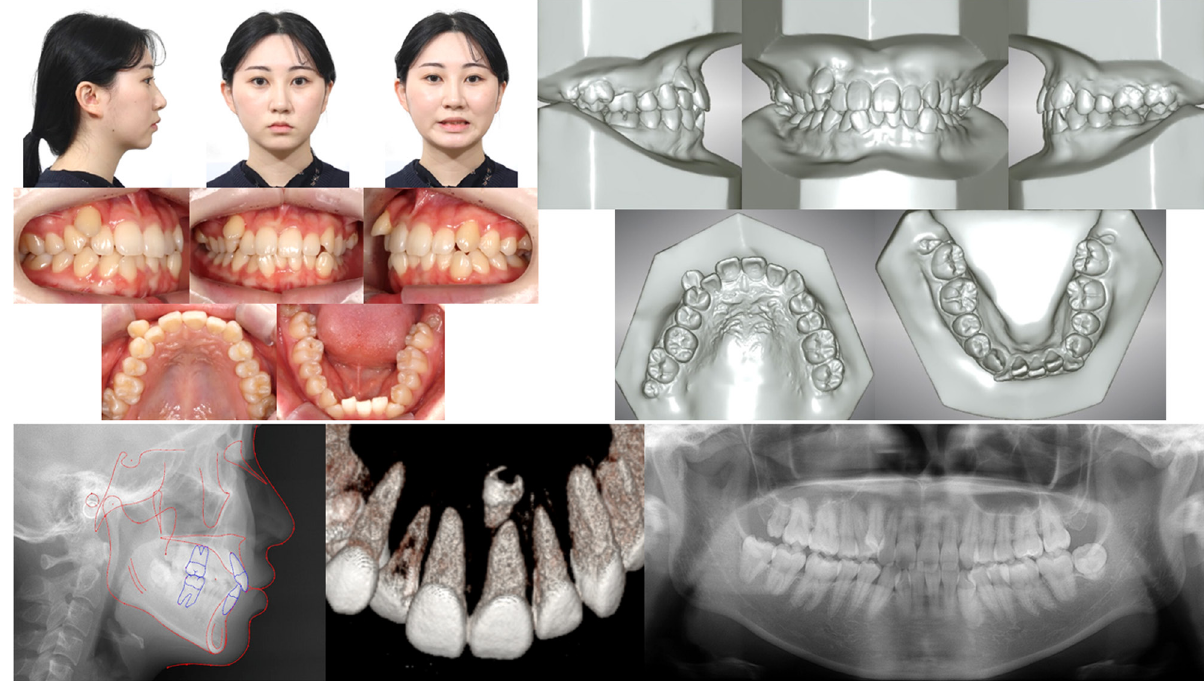
Figure 1. Pre-treatment photographs, dental casts and